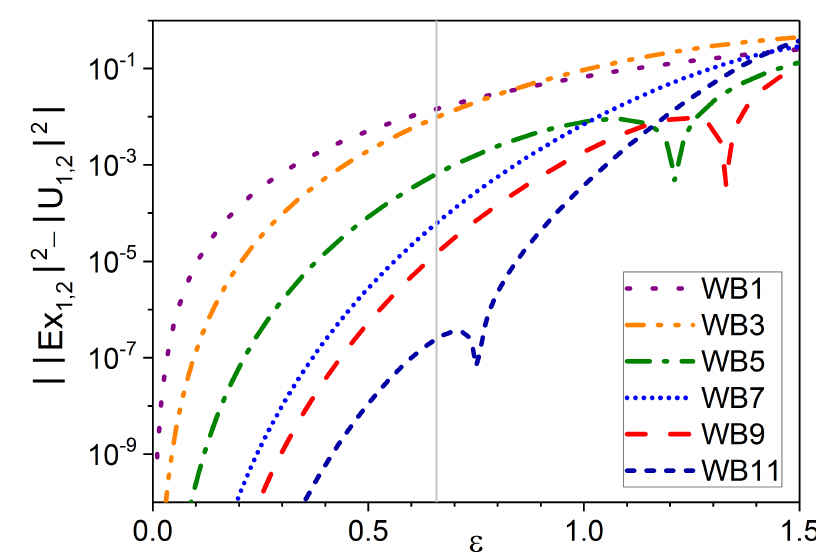
Figure 3. Absolute error of the approximations given by curves in Figure 2 with a = 1. The vertical grey line is located at the value of the convergence lower bound ε =